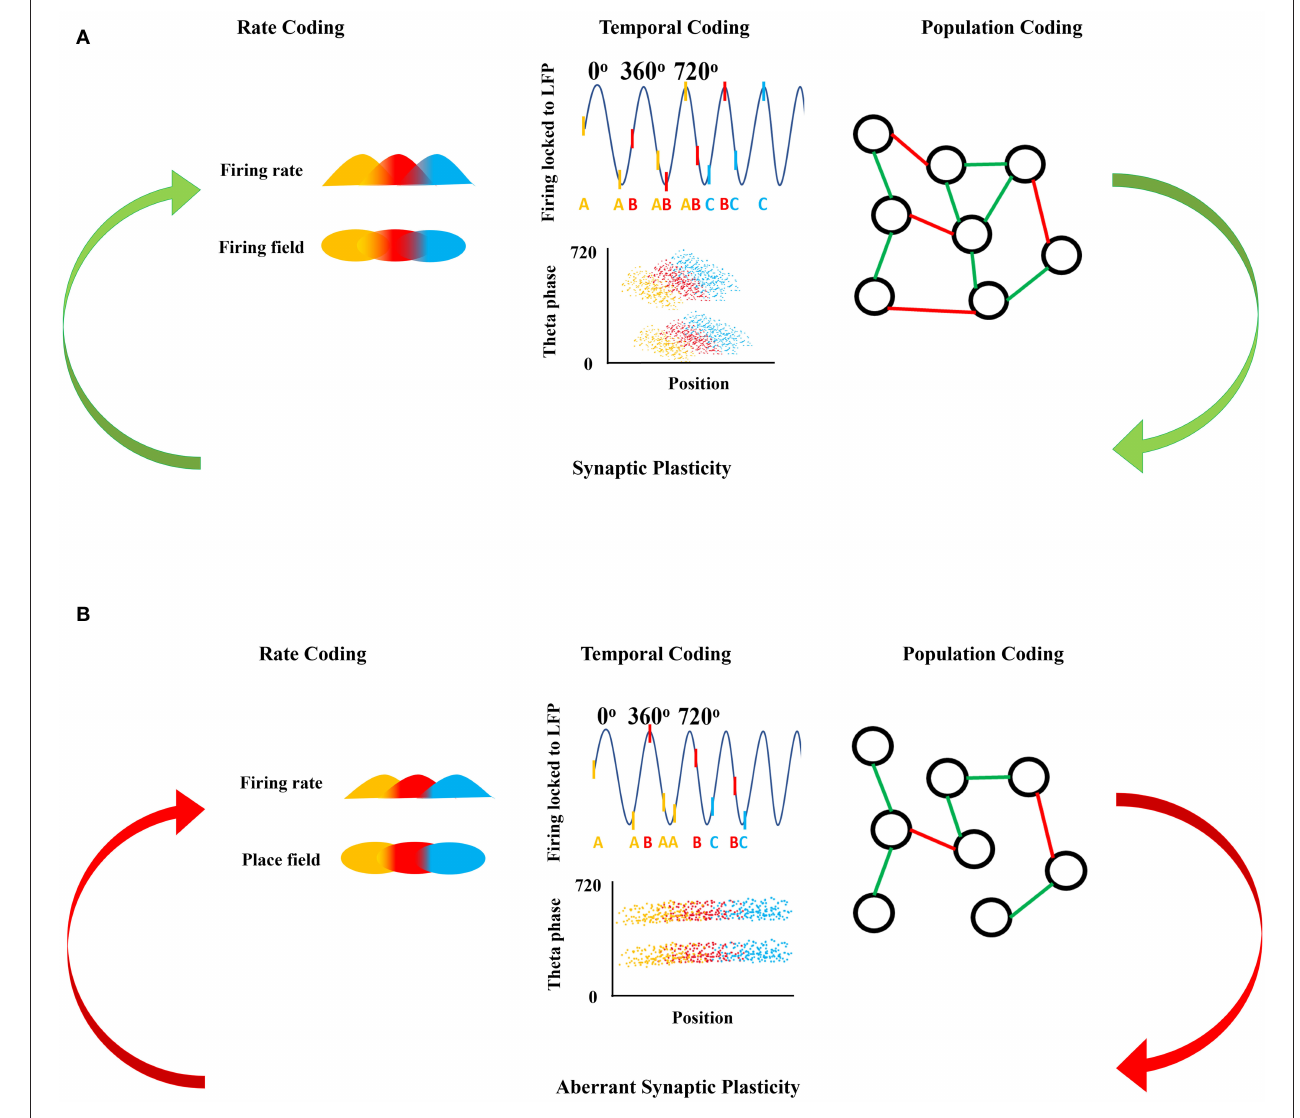
FIGURE 1 | Neuronal firing mechanisms and information processing. (A) Shows the normal information processing and synaptic plasticity feedback loop based on the neural coding mechanisms. Rate coding is shown as the firing rate in time (top) with respect to each firing field in space (bottom) coded by the same color. Temporal coding shows the action potentials as raster ticks riding on the LFP with respect to theta oscillation indicating theta phase precession with each successive peak of theta, with action potentials also represented as a letter at the bottom of the LFP representing firing from the same neuron over time (top). Over many LFP cycles, theta phase precession can be seen in the downward slope of the clouds of dots in the bottom panel, each representing an action potential from three representative neurons show in the top panel. Population coding shows the connections between neurons forming a population network, green representing an excitatory connection between two neurons and red representing an inhibitory connection between two neurons. Synaptic plasticity refines and is refined by these firing mechanisms. (B) Shows the disrupted information processing and synaptic plasticity feedback loop based on the neural coding mechanisms in epileptic brain. In epilepsy, rate coding is disrupted shown here as a decreased firing rate in time with respect to each firing field in space, with decreased overlap in the firing and place fields from each of the three color-coded neurons. Temporal coding is also altered; firing of the colored neurons with respect to theta oscillation is disorganized and there is an absence of theta precession as shown by a flat relationship between the clouds of action potentials from each of the three colored neurons. Population coding shows fewer connections between neurons forming a smaller population network, with potentially different proportions of positive (green) and negative (red) connections in the epileptic brain compared to controls in (A) . Aberrant synaptic plasticity occurs as a result of the aberrant firing